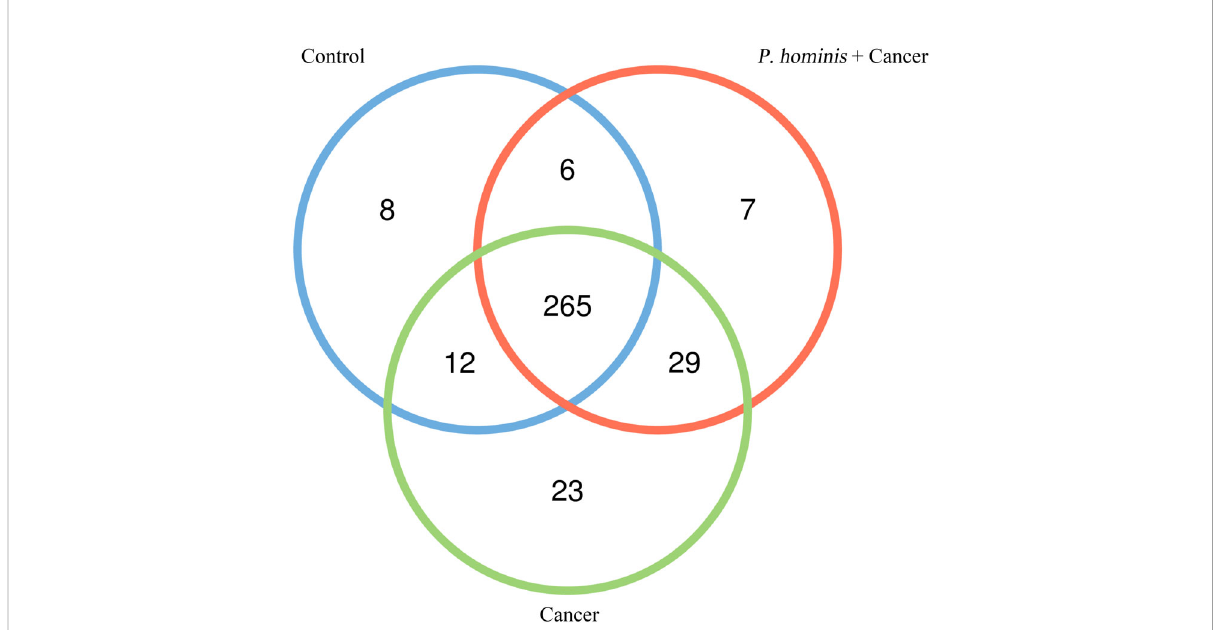
FIGURE 3 Venn diagram based on the OTUs in the Control, Cancer, and P. hominis+ cancer